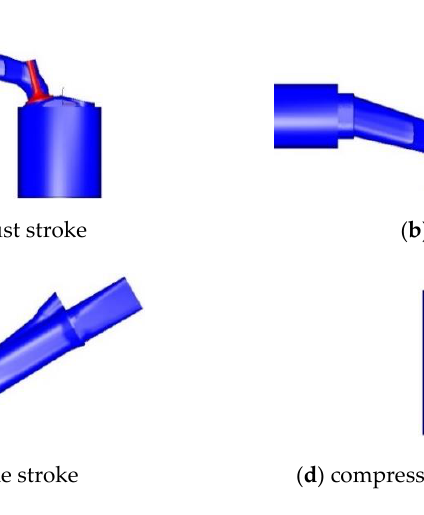
Figure 7. The computational domain.